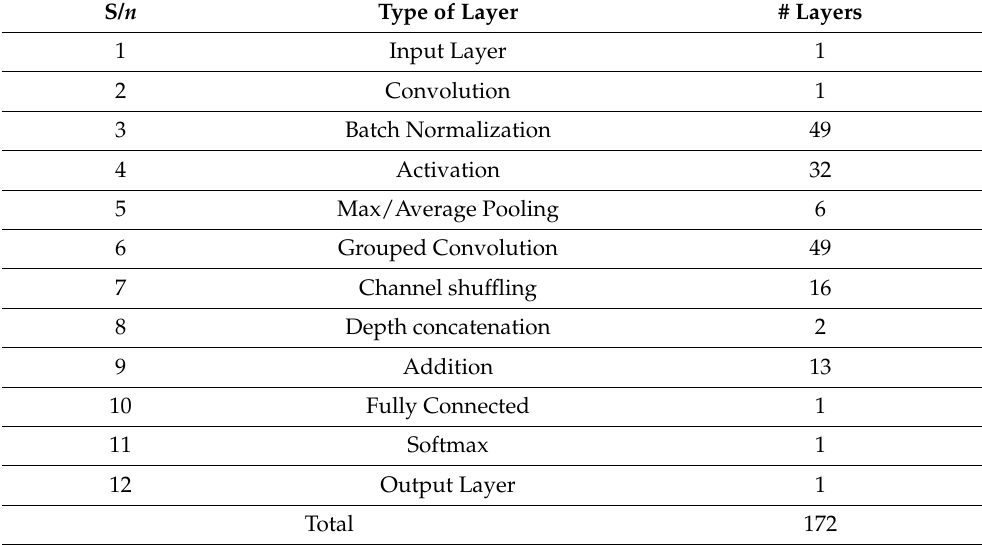
Table 4. Summary of ShuffleNet architecture layers.